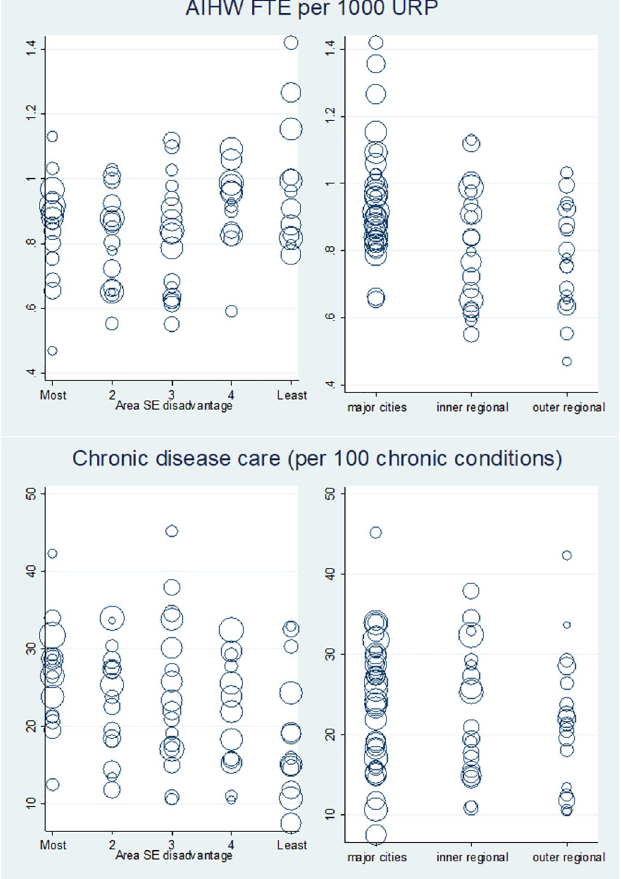
Fig 2. Scatterplots of region and area disadvantage with area PHC service characteristic measures–Availability and comprehensiveness. Abbrev. SE, socioeconomic; AIHW, Australian Institute of health and Welfare; FTE, full- time equivalent; URP, usual resident population; %, percentage: Size of circle is proportional to population of the SA3 plotted; that is, a larger circle indicates a larger population in that SA3.